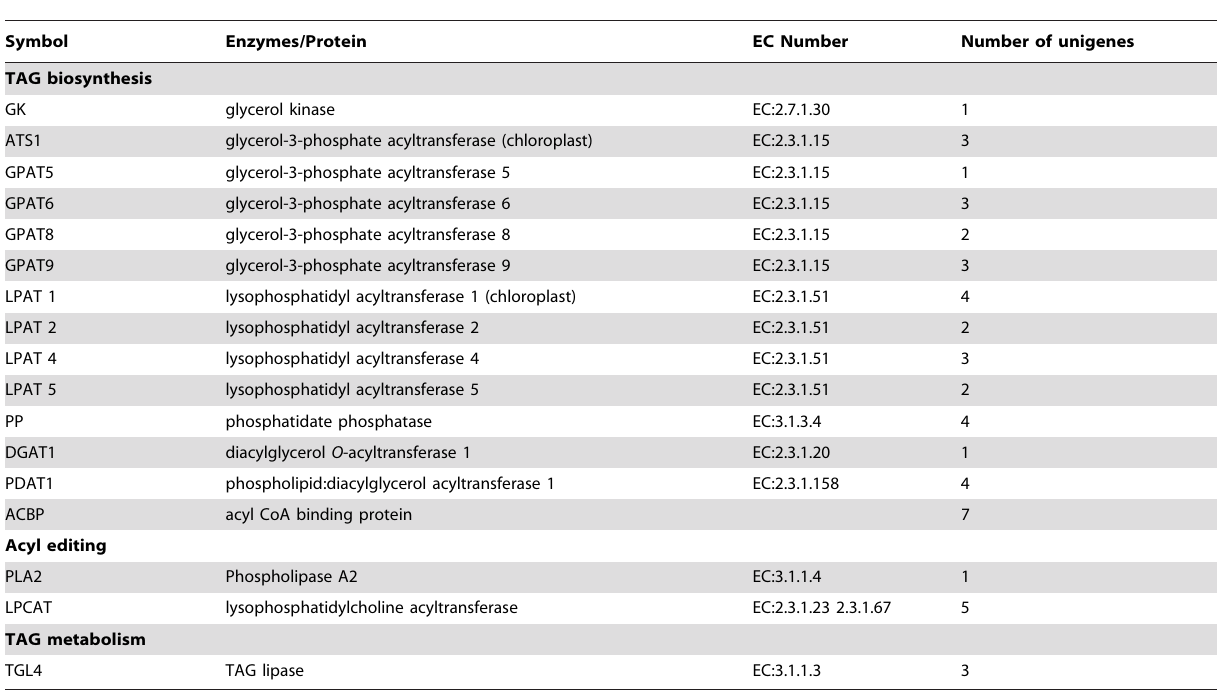
Table 4. Enzymes related to TAG biosynthesis and metabolism identified by annotation of the yellow horn unigenes.